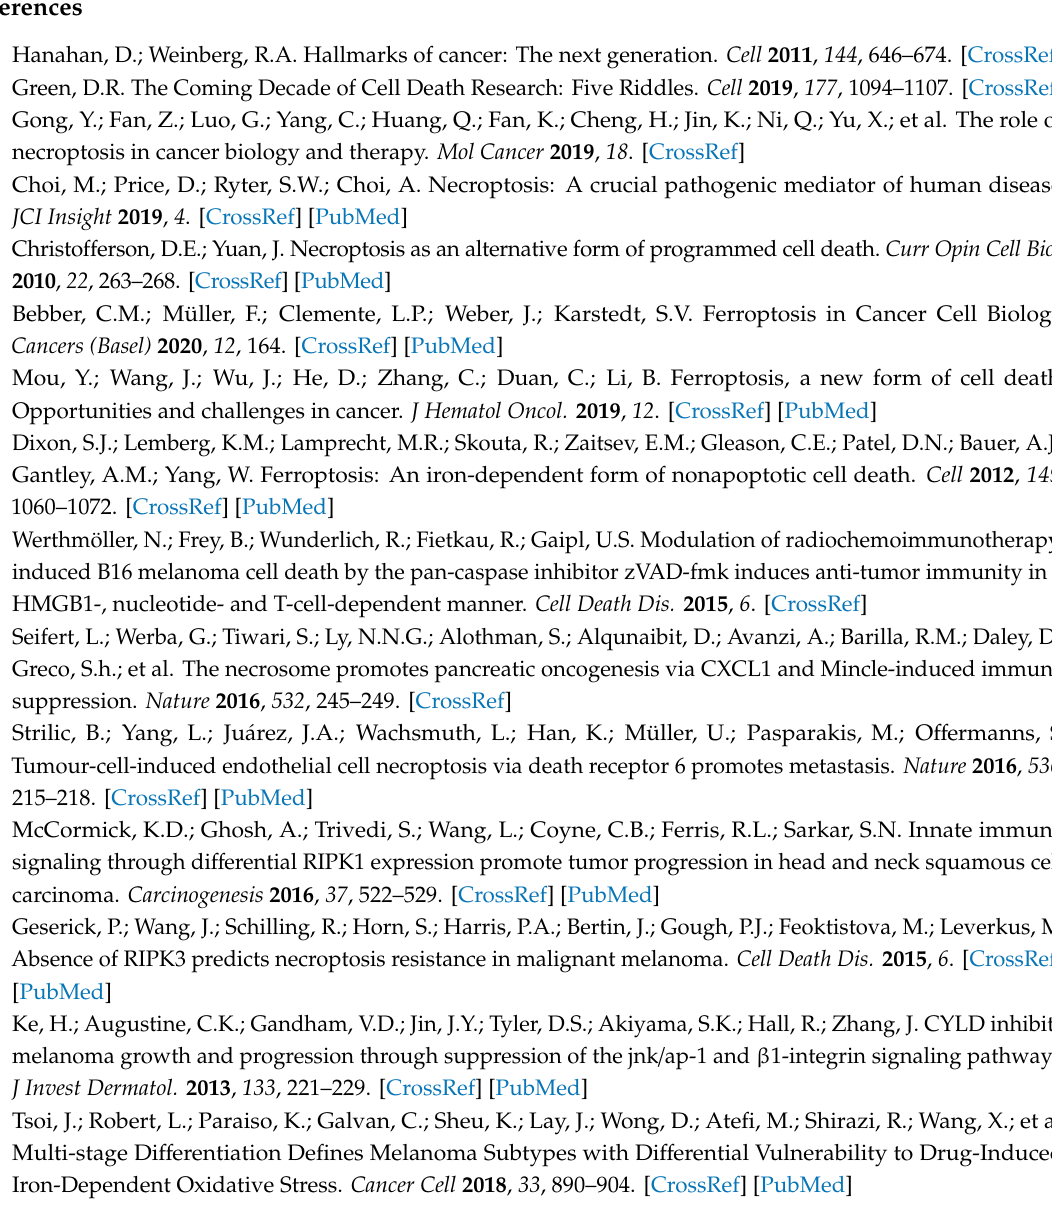
Table S1: Nine DHC-derived features from Training Set. Table S2: Nine DHC-derived features from Test Set 1. Table S3: Nine DHC-derived features from Test Set 2. Table S4: Nine DHC-derived features from Test Set 3. Table S5: Performance of two-node decision tree with each individual Test Set. Table S6: Performance of four-node decision tree with each individual Test